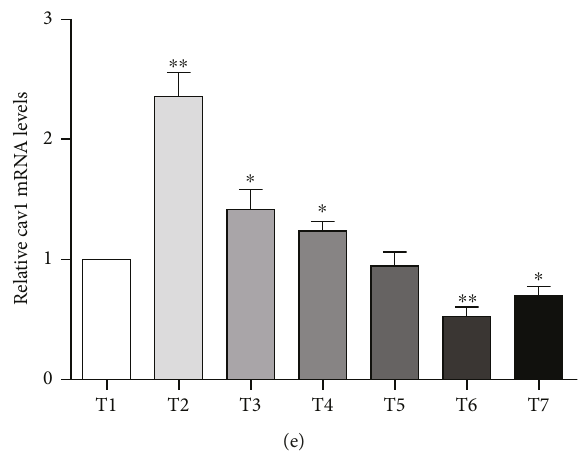
Figure 3: Cav-1 expression and EPC function during the progression of MODS. (a) The relative fold changes of EPC numbers in the control and MODS groups at indicated time points during MODS progression. (b) The relative fold changes of adhesive EPC numbers in the control and MODS groups at indicated time points during MODS progression. (c) Representative images of wound healing assay at indicated time points and its quanti fi cation at indicated time points during MODS progression. (d) Representative images of angiogenesis assay at indicated time points and its quanti fi cation at indicated time points during MODS progression. (e) The cav-1 mRNA levels in EPCs examined by RT- PCR. T1: 24 hours before operation; T2: 12 hours after resuscitation; T3: 24 hours after endotoxemia; T4: 72 hours after endotoxemia; T5: 96 hours after endotoxemia; T6: 144 hours after endotoxemia; and T7: 168 hours after endotoxemia. The data were presented as fold changes of the MODS group relative to the sham group. ∗ P < 0 05 vs.